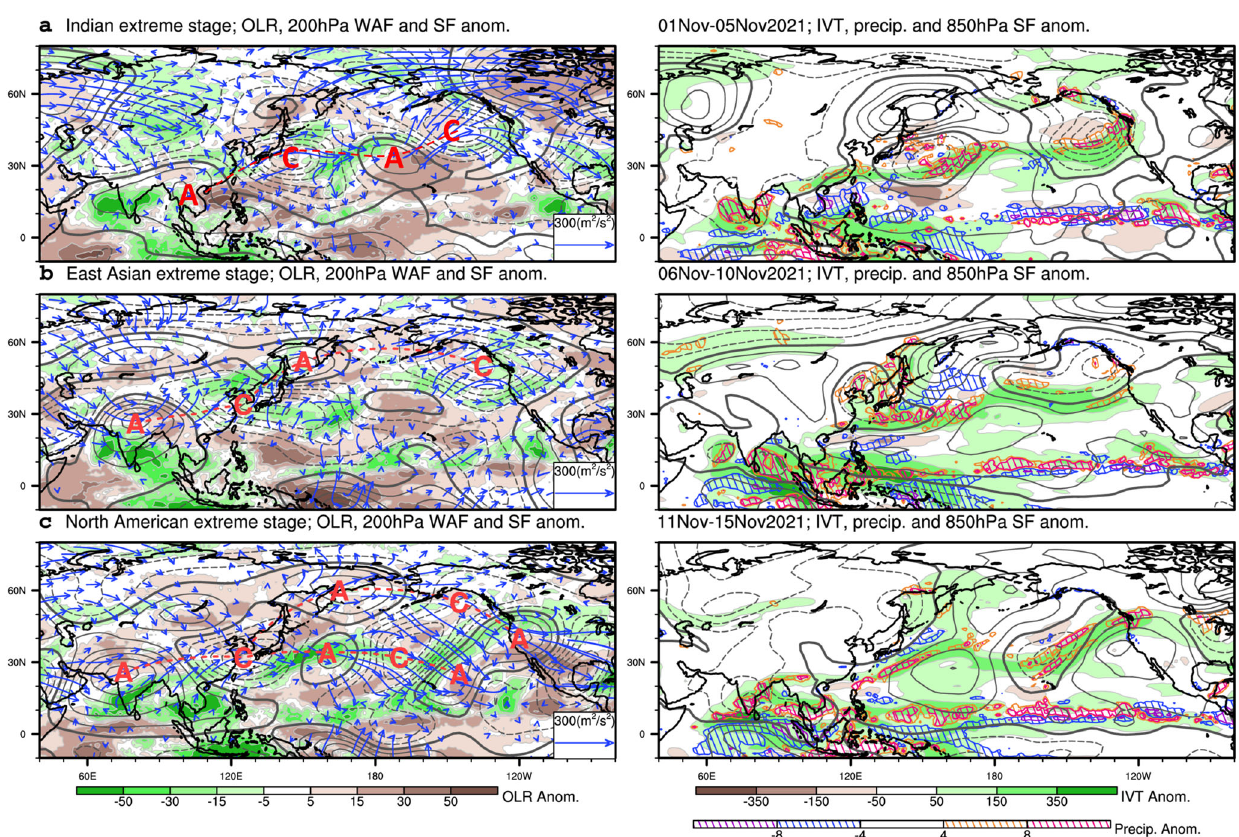
Fig. 2 Intraseasonal evolution of the atmospheric anomalies shown by pentad mean anomalies. During a Indian extreme stage, b East Asian extreme stage, and c North American extreme stage, left panels show OLR anomalies (shading), 200 hPa stream function anomalies (contours at an interval of 5 × 106 m 2 S − 1 ), and wave activity fl ux (vectors) indicating energy propagation. The wave trains are highlighted by the series of A (anticyclone) and C (cyclone). Right panels exhibit atmospheric rivers by the vertically integrated water vapor transport (IVT) anomalies (shading; kg /(m*s)), with precipitation anomalies (slash fi lled; mm/day) and 850 hPa stream function anomalies (contour; 2.5 × 10 6 m 2 S − 1 fl ux diagnosis indicates that the wave energy generated by the Indian heating and Philippine cooling support the anomalous South Asia High and East Asia Low, respectively. The wave energy further propagates northeastward from East Asia Low to enhance the Okhotsk High and Gulf of Alaska Low. This off-equatorial diabatic heating pattern generates the Rossby wave train more effectively than equatorial heating. For comparison, we speci fi ed a heat source over the equatorial Maritime Continent centered at (10°S, 110°E). The equatorial heating produces a teleconnection pattern that mainly affects the southern hemisphere with a minor impact on the northern hemisphere (Supplementary Fig. 2).